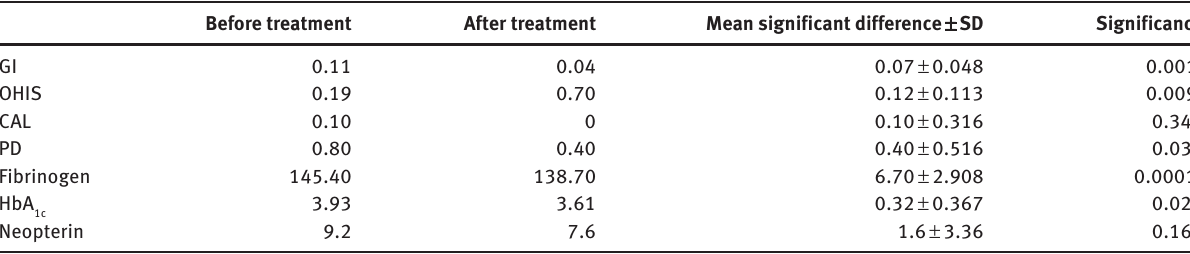
Table 4: Intragroup comparison of all variables before and after treatment in group